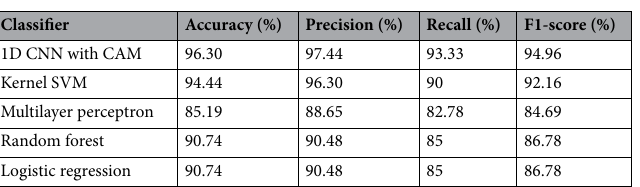
Table 5. Performance of several classifiers for electrospray mode prediction.